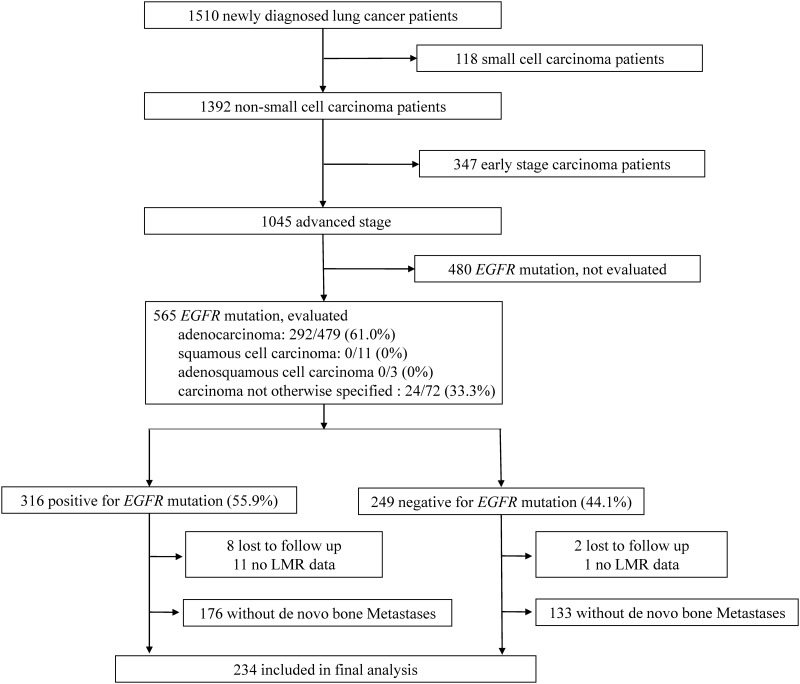
The inclusion and screening for this study.Among 1,510 patients who were diagnosed with non-small-cell lung cancer between November 2010 and March 2014, 234 patients with de novo bone metastases were included in the final analysis.